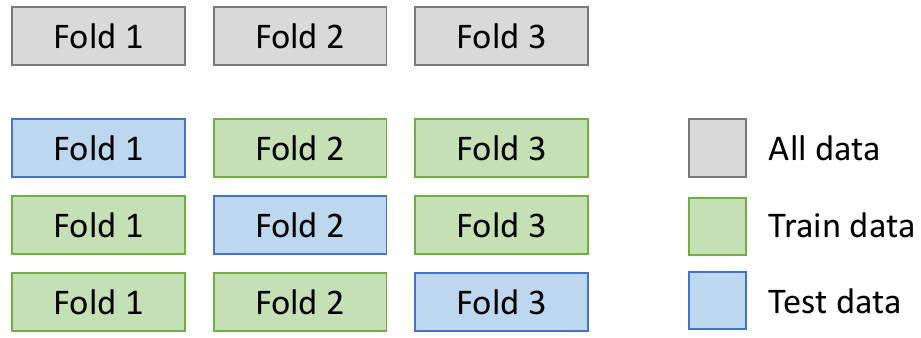
Figure 4. K-fold cross validation